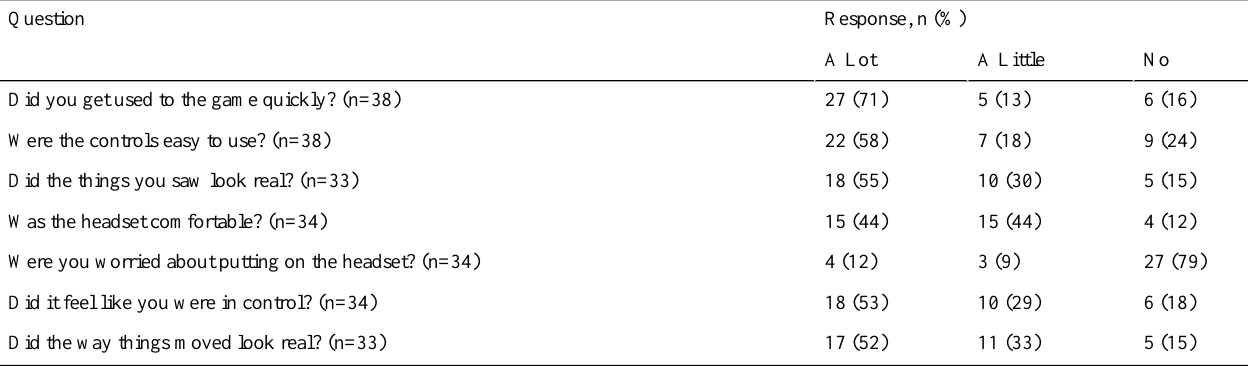
Table 4. Patients’responses to a variety of virtual reality feasibility